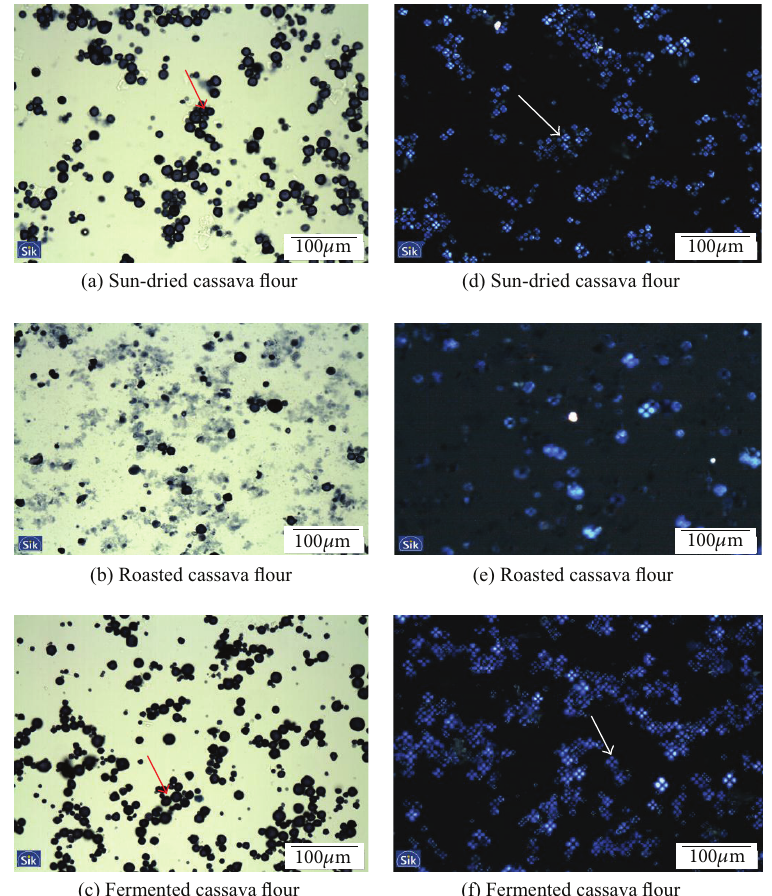
Figure 5: Bright-field (a, b, and c) and polarized Light (d, e, and f) micrographs of starch granules. Sun-dried and fermented cassava flour with intact granules ((a) and (c), red arrows) and roasted cassava flour with partly swollen granules, few Maltese crosses (e) compared with (d) and